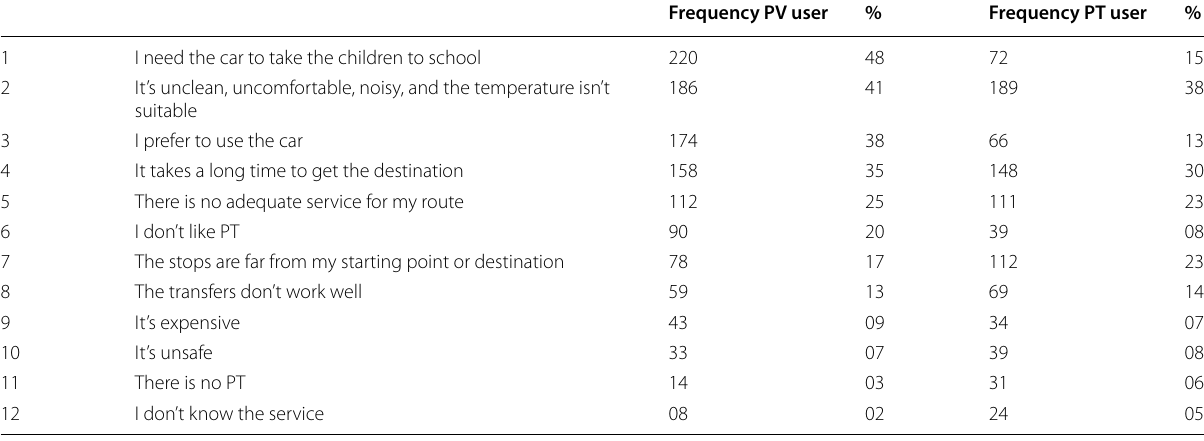
Table 6 A comparison between the PV and PT users explaining a low user frequency of PT